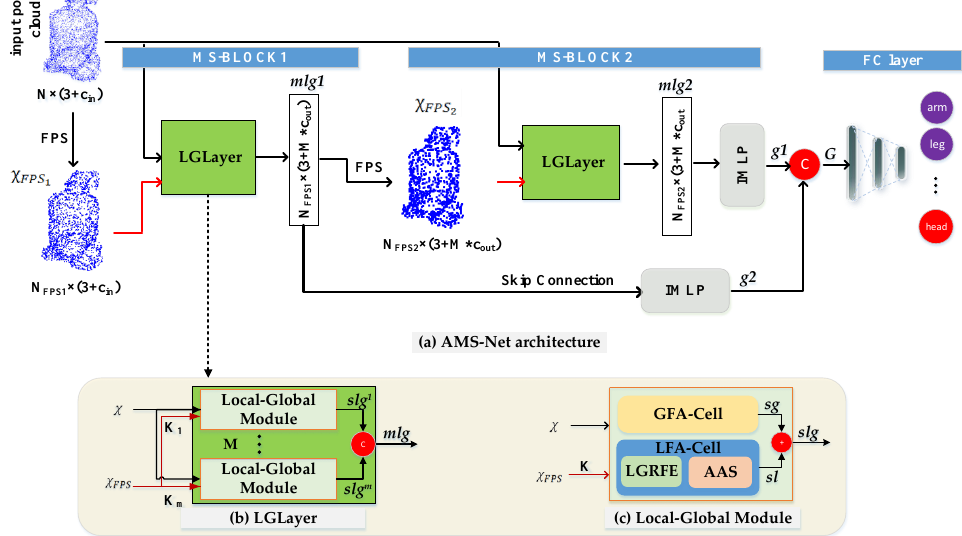
Figure 2. The framework of our AMS-Net to classify the Terracotta Warrior fragments.